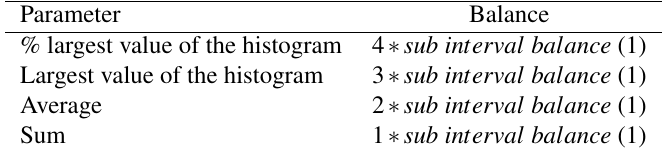
Table 1. Parameters balance 1 The sub interval balance is obtained by applying the criteria in Table 2 for each parameter.